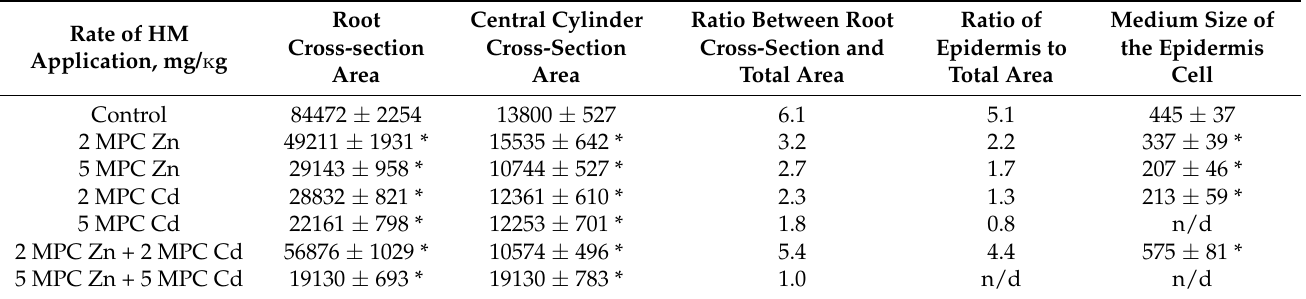
Table 2. Cytomorphometric indices of the H. vulgare grown at different levels and contamination of the soil by Zn and Cd, µ m